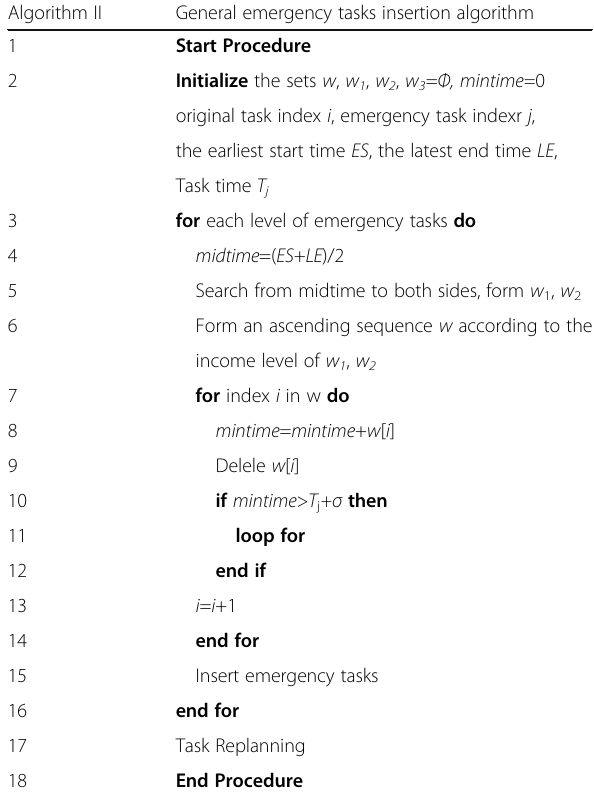
Table 2 General emergency tasks insertion algorithm Algorithm II